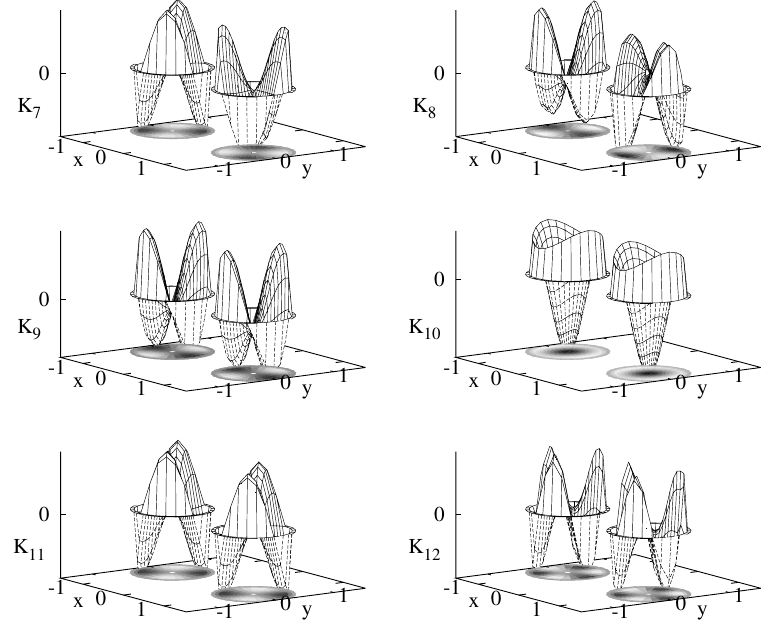
Fig. 6. The basis functions K 7 to K 12 for q = 1 = 2. (cid:21) 2 0.00377, 0.00376, 0.00340 and 0.00168 for j = 7 to